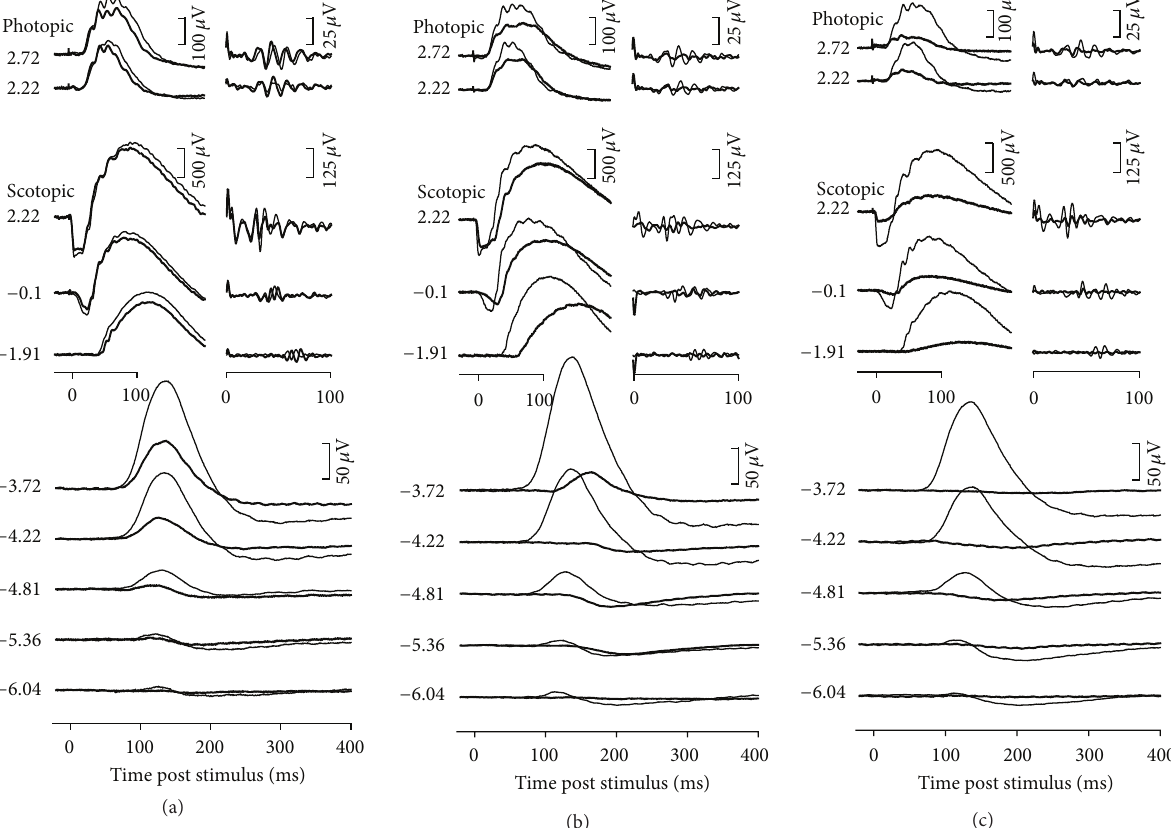
F 10: Effect of chronic IOP elevation on the rat ERG. Representative individual examples of ERG �ndings for experimental eyes (bold traces) and fellow control eyes (thin traces). Examples are given for eye showing mild (a), moderate (b), and high (c) IOP elevation. Stimulus �ash intensities are listed at le� for scotopic and photopic responses. Isolated OPs are shown to the right of corresponding waveforms. Reproduced with permission from